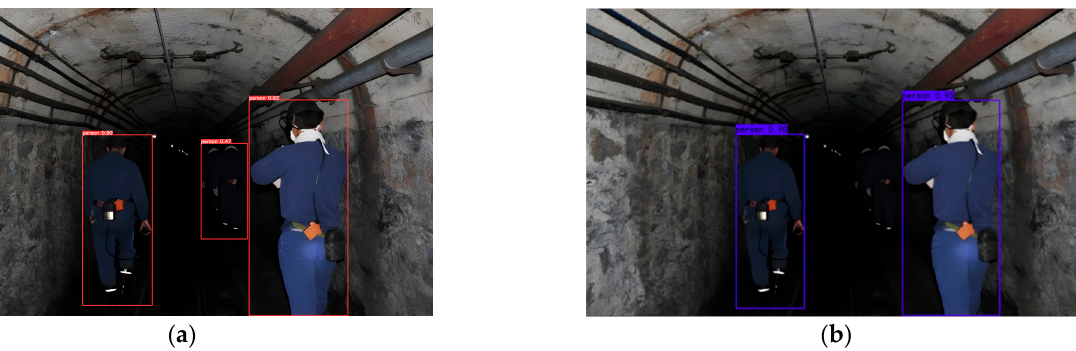
Figure 15. Cloud and edge-side detection results. ( a ) Cloud detections. ( b ) Edge-side